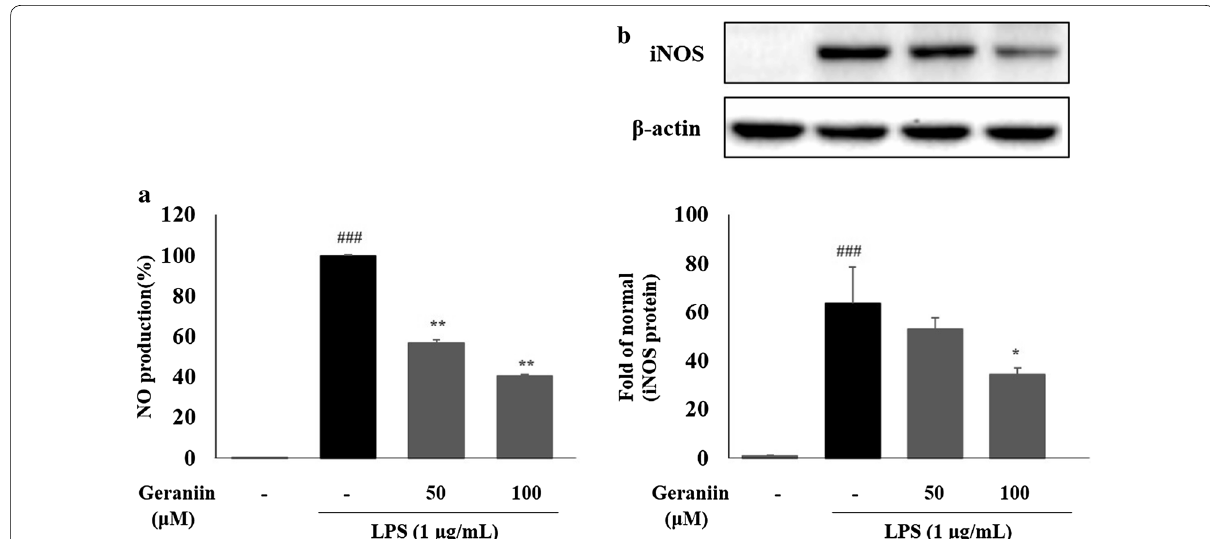
Fig. 2 Inhibition of NO production ( a ) and expression of iNOS protein ( b ) in LPS-induced Raw 264.7 cells. Cells pre-treated with geraniin 50 and 100 µM for 24 h. Data are mean standard deviation (SD); ### p < 0.001 compared with normal control cells; **p < 0.01, and *p < 0.05 compared with ± LPS control